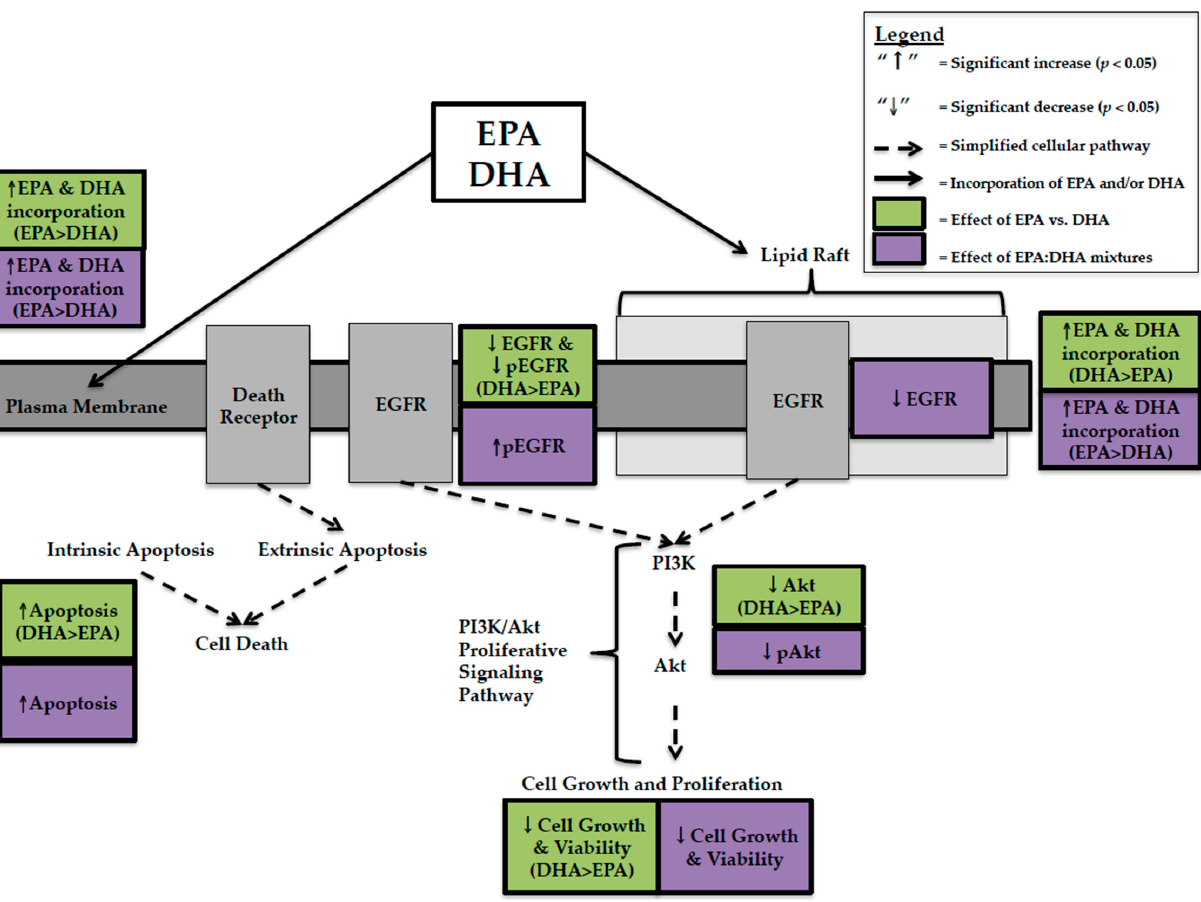
Figure 1. Schematic illustrating the pleiotropic effects and relative efficacy of eicosapentaenoic Acid (EPA) and/or docosahexaenoic Acid (DHA) in MDA-MB-231 human breast cancer cells. EGFR = Epidermal Growth Factor Receptor; pEGFR = Phosphorylated EGFR; PI3K = Phosphoinositide-3-kinase; Akt = Protein Kinase B; pAkt = Phosphorylated Akt.